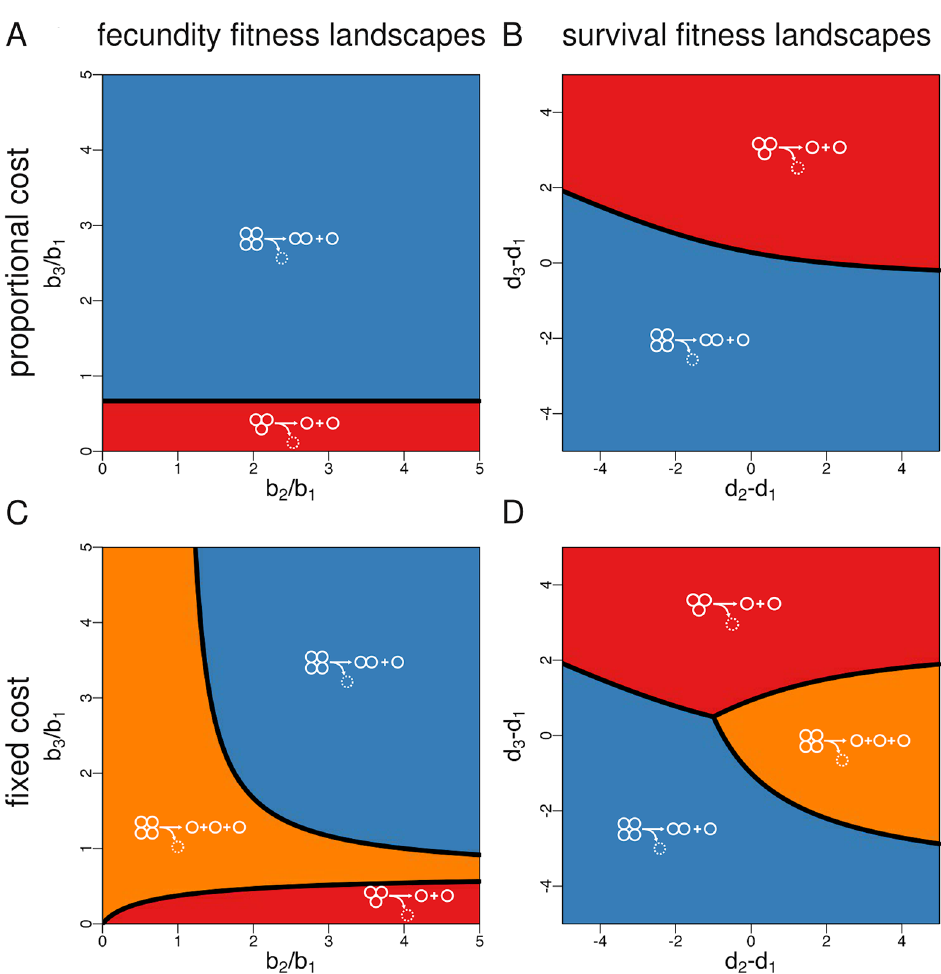
Fig 4. Optimal fragmentation modes for fecundity and survival landscapes (costly fragmentation). For proportional costs (panels A and B ), splittinginto π parts involvesthe loss of π − 1 cells. In this case, and for n = 4, only two pure modes are possible:2+1 (wherebya 4-unit group splits into a pair of cells and a singlecell and loses one cell) and 1+1 (whereby a group of three splits into two single cells and loses one cell). For fixed costs (panels C and D ), splittinginvolvesthe loss of a single cell, no matter the kind of partition.In this case, and for n = 4, an additionalmode is possible:1+1+1 (wherebya 4-unit group splits into three single cells and loses one cell). This last nonbinarymode can be optimalunder a wide range of